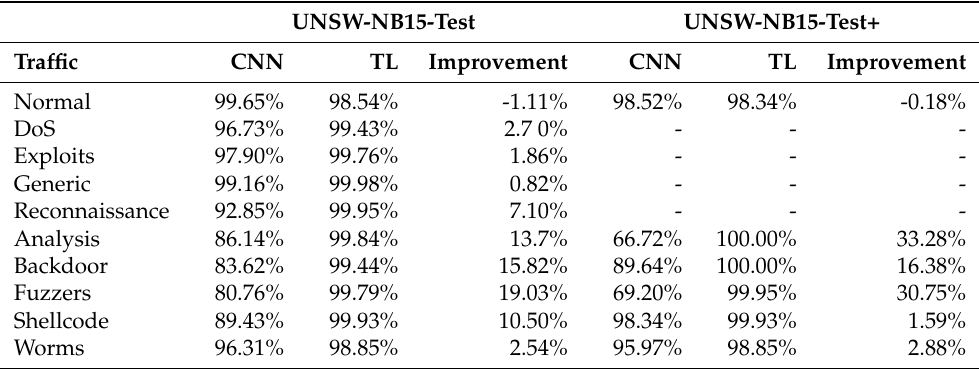
Table 12. Attack detection rate for known and zero-day